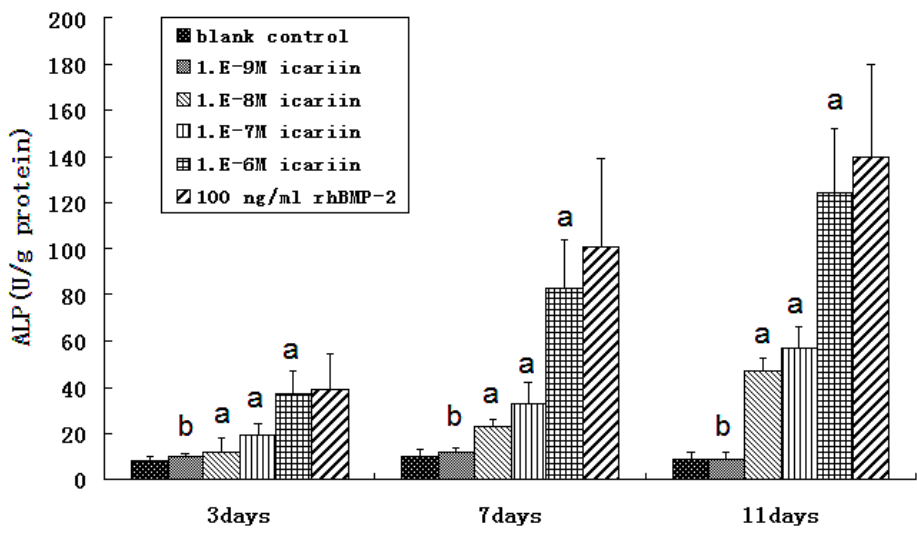
Figure 6. The expression of ALP (n = 6).